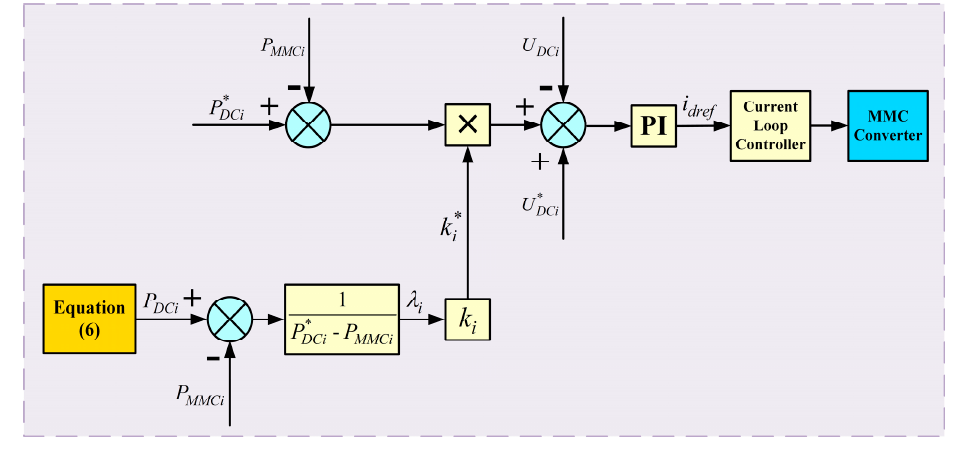
Figure 4. Adaptive droop control of the MMC.